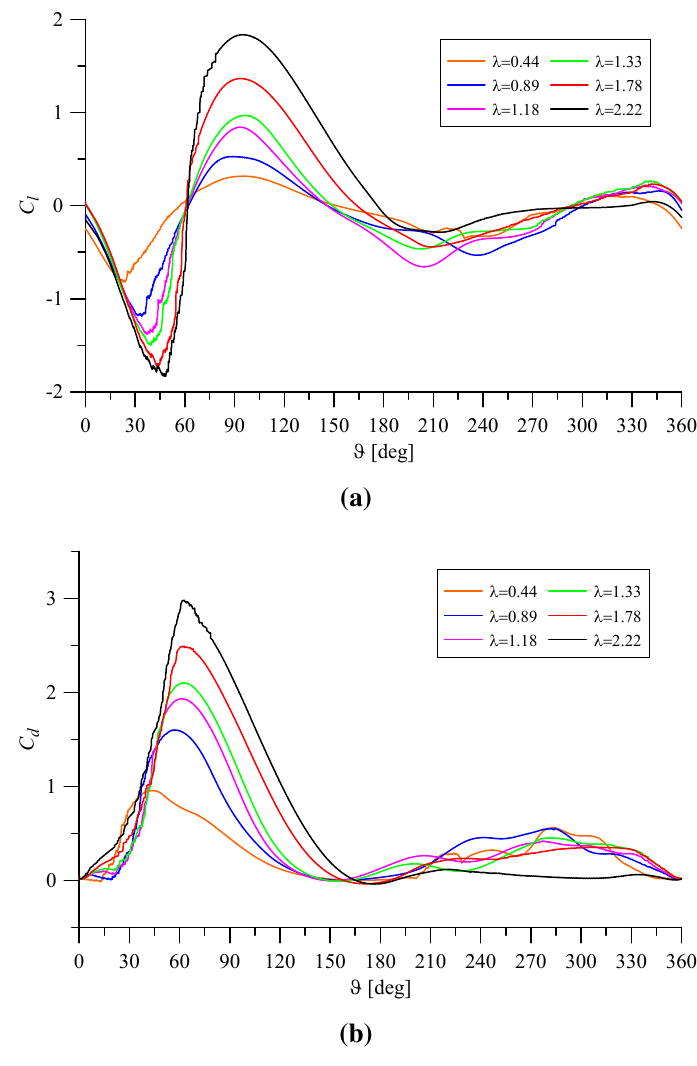
Figure 5. Lift and drag coefficients of airfoil over one turbine revolution for different λ . ( a ) Lift coefficient ( C ) with respect to the azimuthal position; ( b ) drag coefficient ( C l respect to the azimuthal